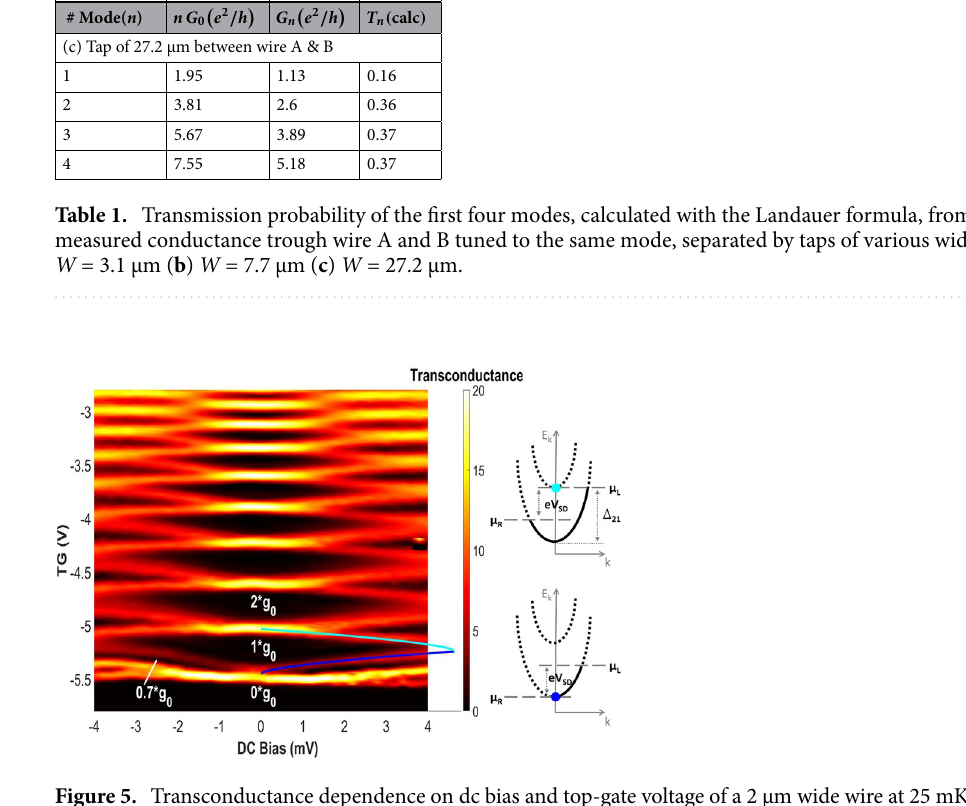
G 0 ( 1 + T n ) and the transmission probability can Fig. 4a,c. The Landauer formula can now be written as G n = 2 n be calculated from the measured conductance values through wire A & B with respect to the values of only wire A. For purely ballistic transport, the transmission probability would be 1 for each mode. In contrast, diffusive transport resulting in the ohmic addition of resistances of the two wires, has a transmission probability of 0. The calculated transmission probabilities of the first four modes with W = 3.1, 7.7, and 27.2 μm are summarized in table 1. From these results one can see a clear evolution from ballistic to diffusive dominated transport as the tap size increases. In addition, we have performed dc bias measurements on a single CED wire. Figure 5 shows the transcon- ductance ( dG / dV TG ) plotted as a function of the additional dc bias between source and drain ( V SD ), and the top-gate voltage ( V TG ). The transconductance describes the sensitivity of the conductance with respect to the charge density in the wire. The dark areas in the plot characterize regions of different conductance values, which are separated by high transconductance regions (red-white) where the gate voltage dependence is strong. The different conductance values are given in multiples of the conductance quantum, G 0 = 2 e 2 / h . Between the zero-conductance state and the first step, a clear conductance peculiarity, called ,, 0.7 structure”, can be seen